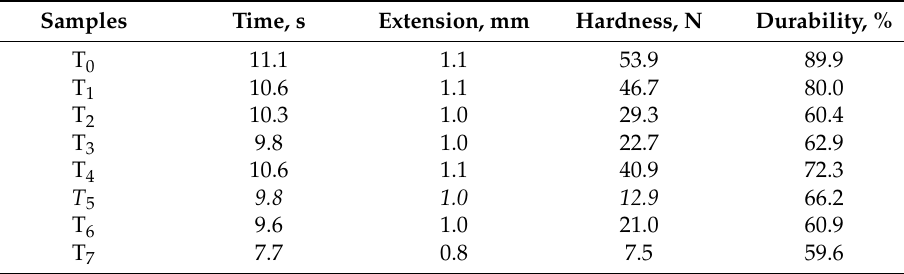
Table 4 . Hardness and durability of pellets.